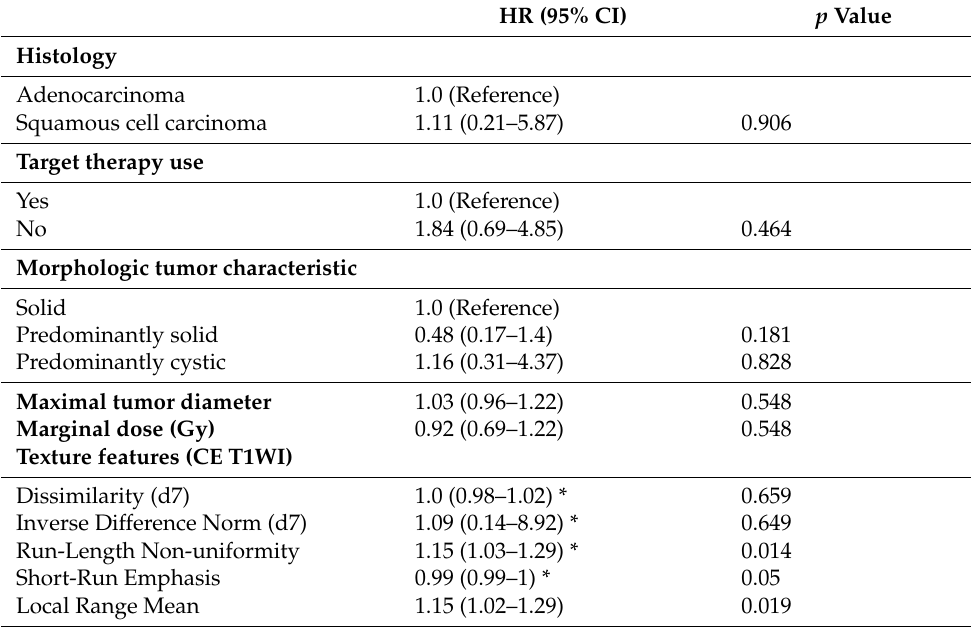
Table 4. Multivariable Cox proportional hazards regression analysis of factors affecting local progression-free survival in the NSCLC